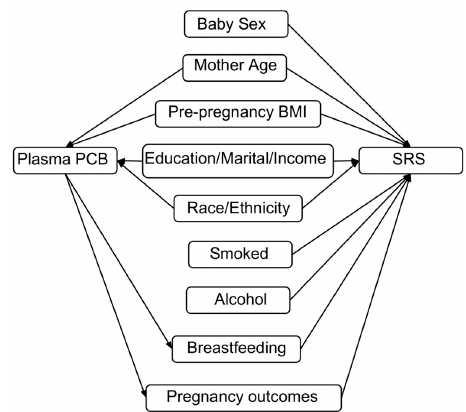
Figure 1. Directed Acyclic Graph (DAG) for the relation between plasma PCB exposure during pregnancy, the SRS score, and participant variables.